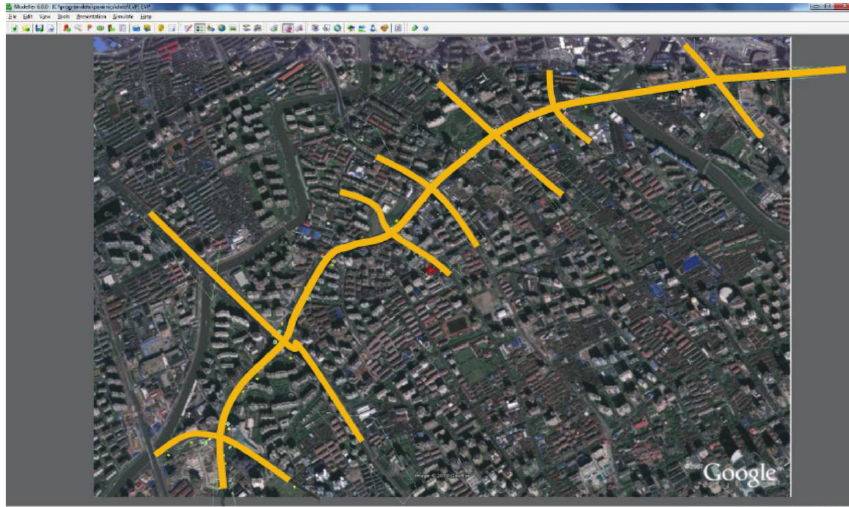
Figure 6: The snapshot of evacuation route.